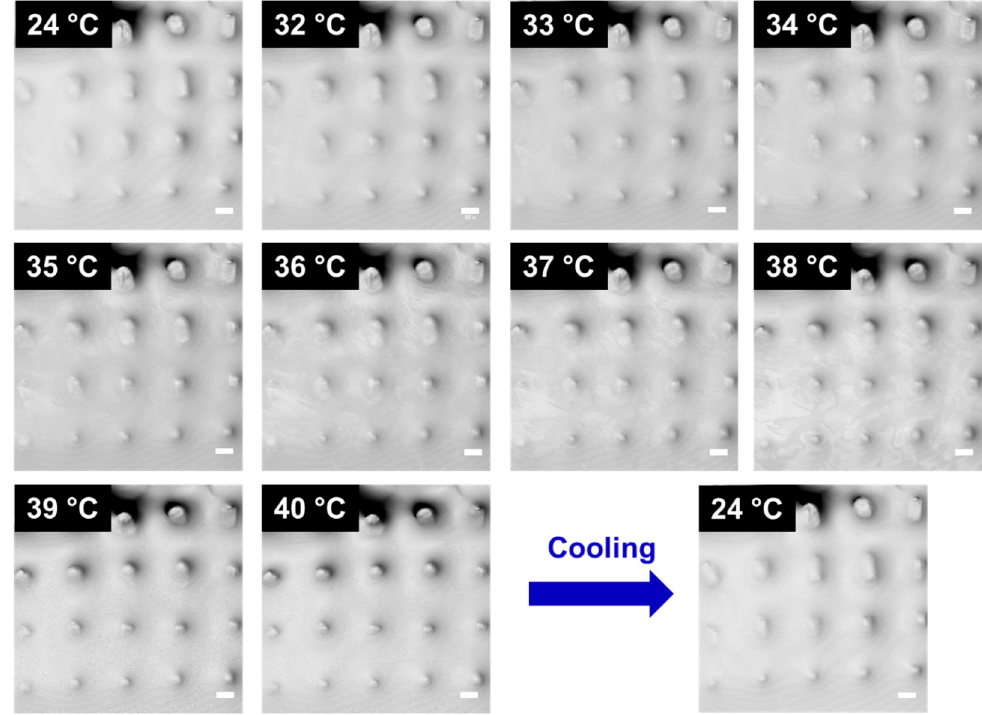
Figure 7. Top-view micrographs of the microlens array with topographical changes at various temperatures. The scale bar is 50 μ m.